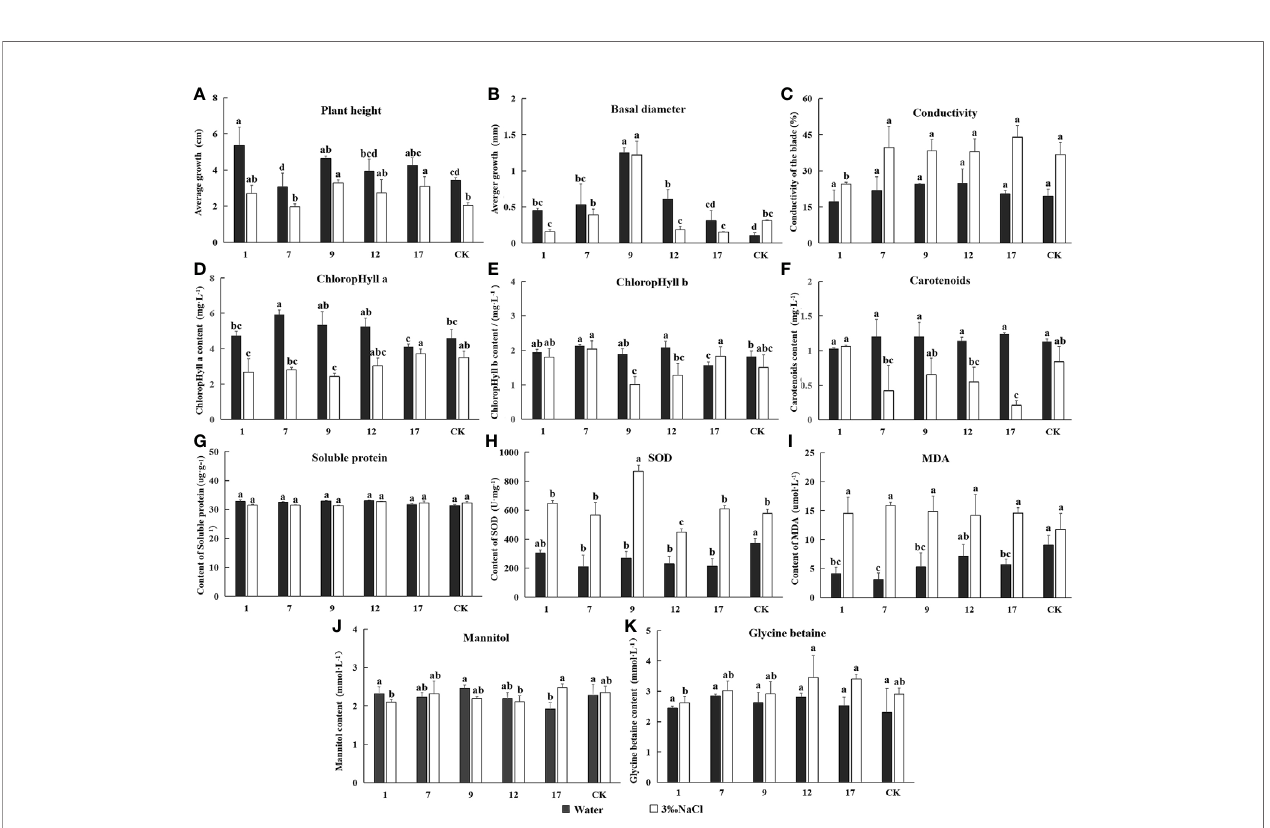
FIGURE 7 | The determination of Eleven indicators related to salt tolerance. Experimentally determined the indexes under the treatment of water and 3 ‰ NaCl concentration. In the diagram, gray represents water treatment and white represents 3 ‰ NaCl treatment. 1, 7, 9, 12, and 17 stands for fi ve transgenic lines; CK, non-transgenic line. Data are means of three biological replicates of each line, error bars represent the standard deviation of the mean. According to Duncan ’ s multiple range test ( p < 0.05), different letters indicate signi fi cant differences and the same letters indicate no signi fi cant differences between the lines. (A) Bar chart of plant height determination results. (B) Bar chart of ground diameter determination results. (C) Bar chart of leaf conductivity determination results. (D) Bar chart of ground diameter determination results. (E) Bar chart of contents chlorophyll a determination results. (E) Bar chart of contents chlorophyll b determination results. (F) Bar chart of contents carotenoids determination results. (G) Bar chart of superoxide dismutase (SOD) activity determination results. (H) Bar chart of malondialdehyde (MDA) activity determination results. (I) Bar chart of soluble protein content determination results. (J) Bar chart of mannitol content determination results. (K) Bar chart of glycine betaine content determination results.